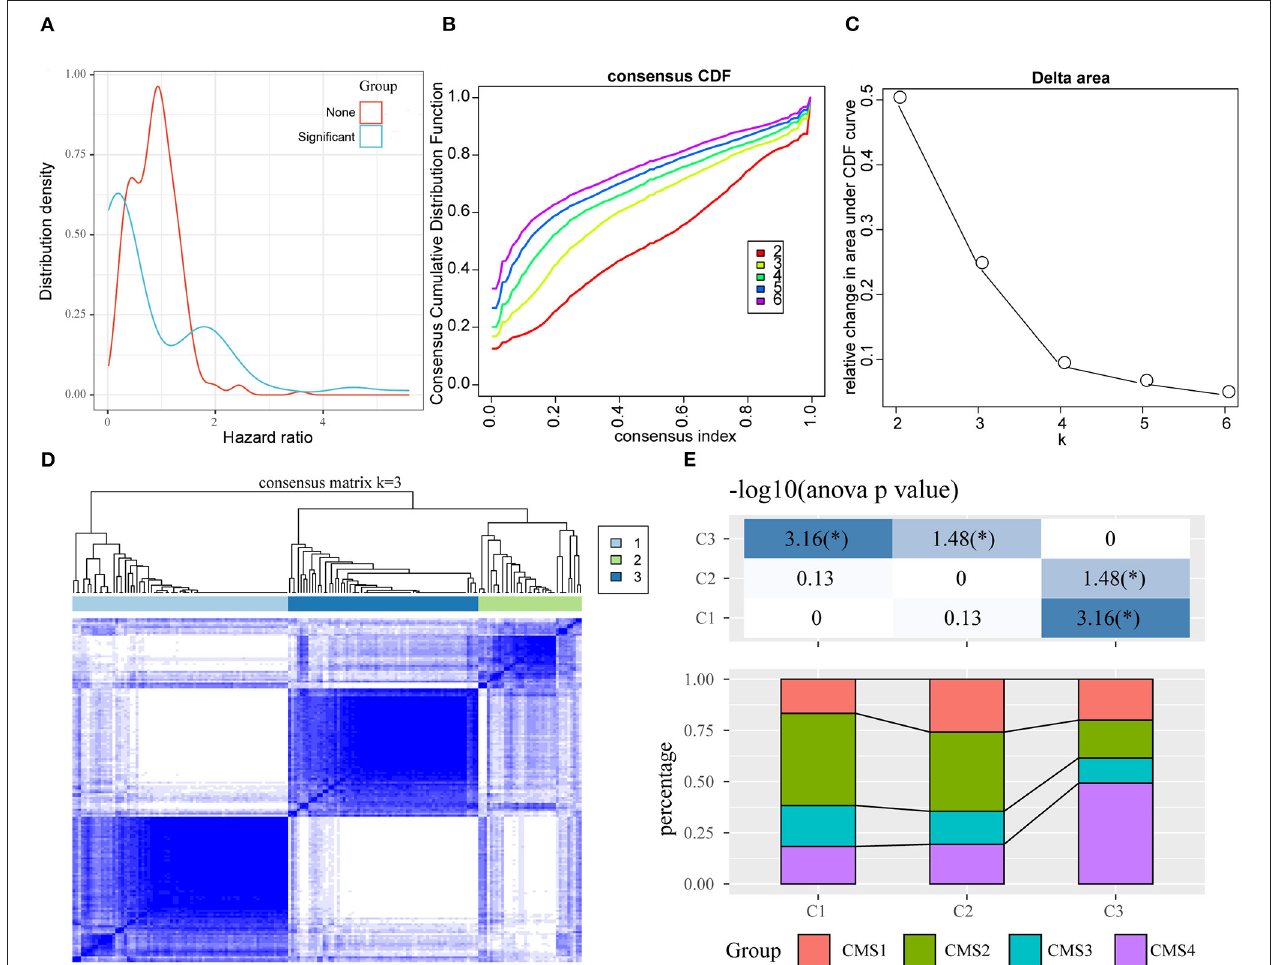
FIGURE 3 | Identification of oxaliplatin resistance-associated subtypes of colon cancer in the training set. (A) The hazard ratio (HR) distribution of genes related to oxaliplatin resistance, wherein “Sig” represents the HR distribution of genes significantly related to prognosis and “None” represents the HR distribution of genes not significantly related to prognosis. (B) The cumulative distribution function (CDF) curves of consensus scores based on different subtype numbers (k = 2 ∼ 6) and the corresponding color are represented, which could help us determine the choice of k when the CDF reaches the maximum (aiming to reach the maximal consistency and cluster confidence). (C) The comparison of the relative changes of the area under the CDF curve between k and k − 1, which can help users determine the relative increase in consensus and the value of k with significant increase. (D) The consensus score matrix of colon cancer samples when k = 3 (1 = C1, 2 = C2, 3 = C3). (E) The distribution of samples from the three subtypes in the CMS